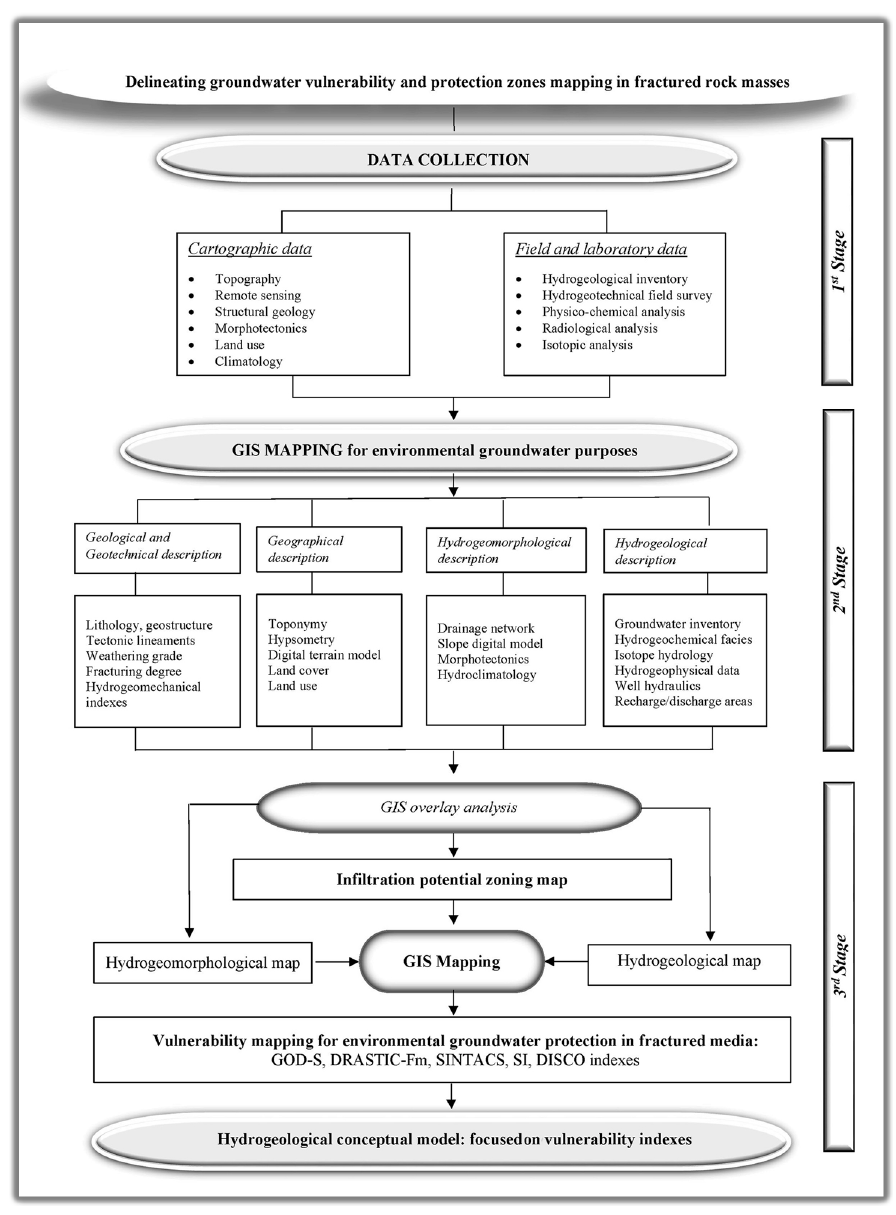
Figure 2. Conceptual flowchart representing the methodology used in the study.